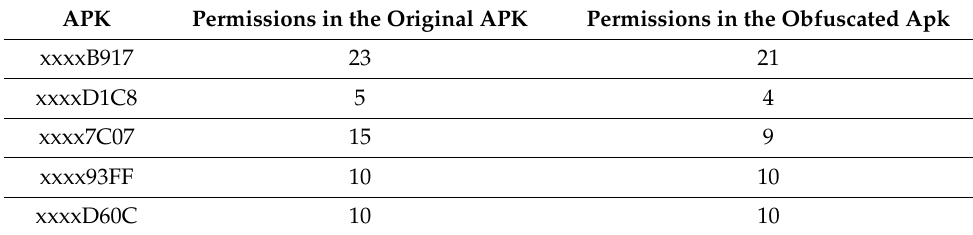
Table 9. Comparison of permissions in the manifest file of the original APK with the obfuscated APK.